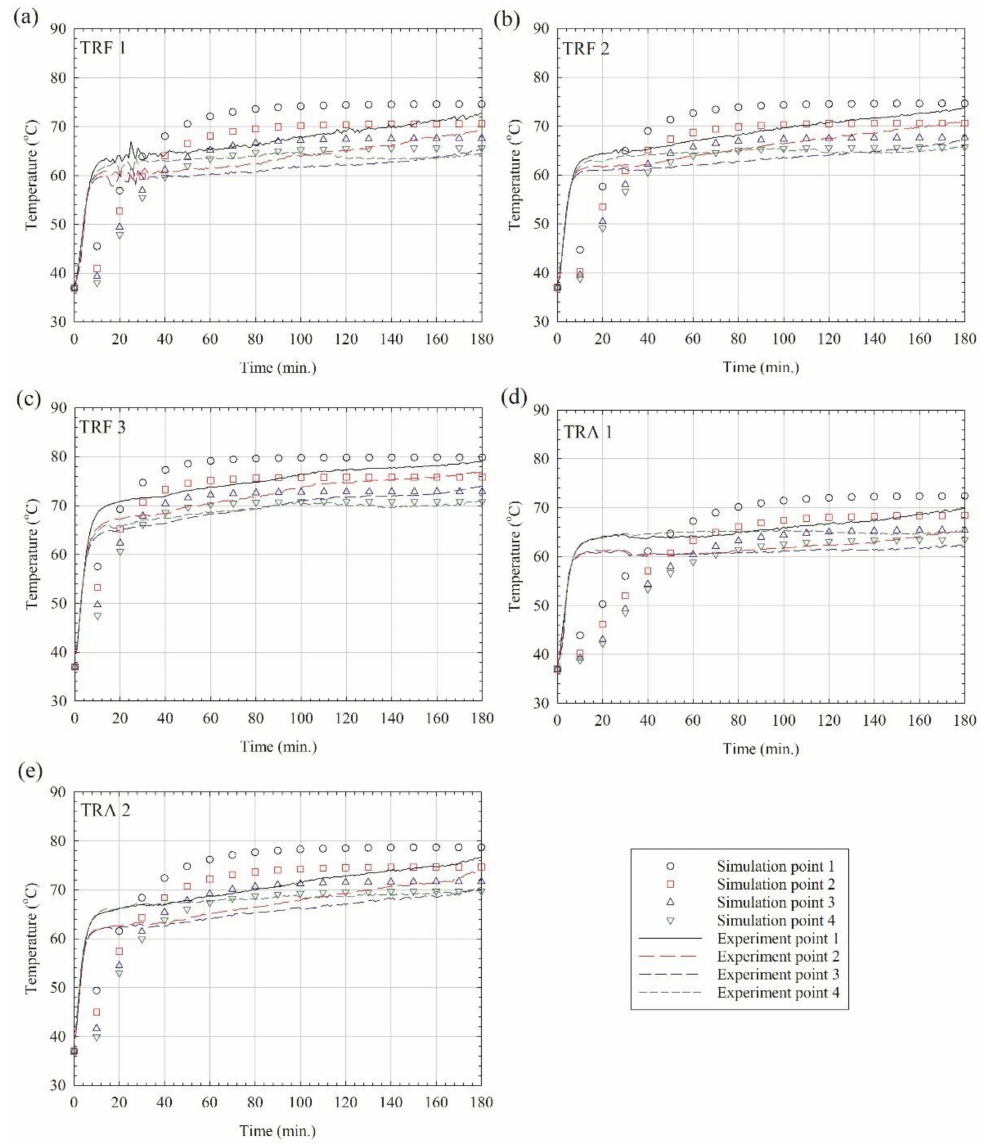
Figure 8. Variation in temperature distribution of ( a ) TRF1, ( b ) TRF2, ( c ) TRF3, ( d ) TRA1, and ( e )